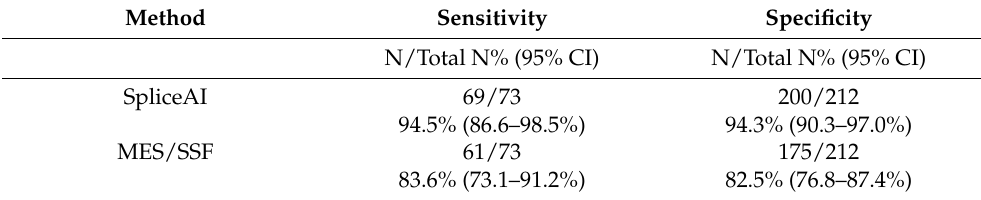
Table 2. Performance of SpliceAI and MES/SSF for predicting NF1 splice